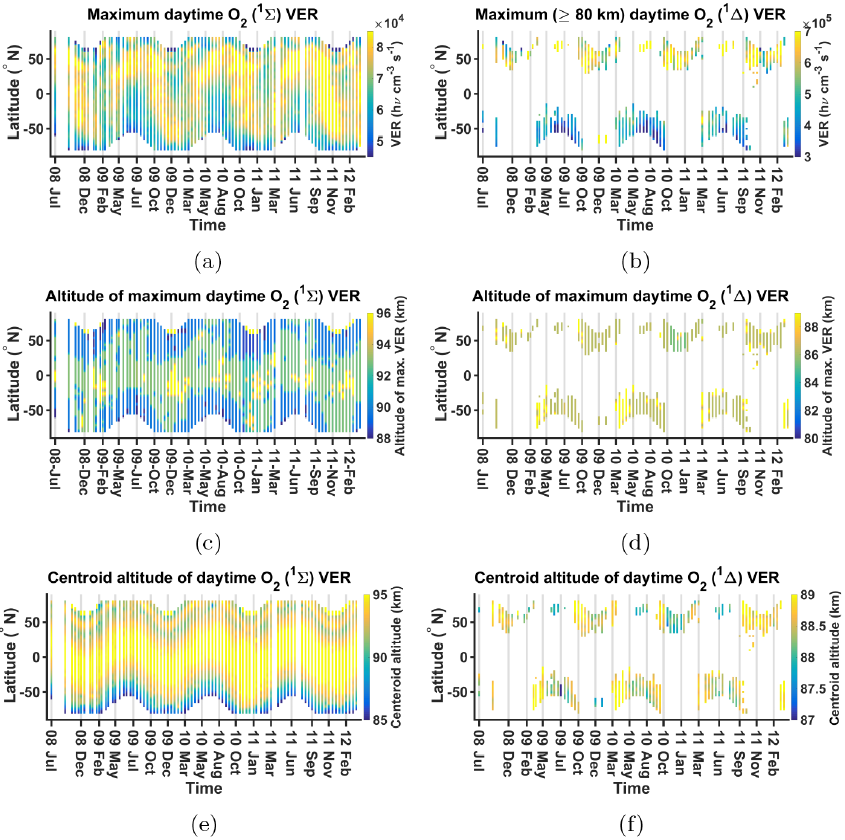
Figure 8. (a) Time series of the maximal daily mean O 2 ( 1 (cid:54)) VER. (b) as (a) for the O 2 ( 1 (cid:49)) band. (c) Time series of the altitudes of the maximum daily mean O 2 ( 1 (cid:54)) VER. (d) as (c) for the O 2 ( 1 (cid:49)) band. (e) Time series of the centroid altitudes of the daytime O 2 ( 1 (cid:54)) daily mean VER (km). (f) as (e) for the O 2 ( 1 (cid:49))